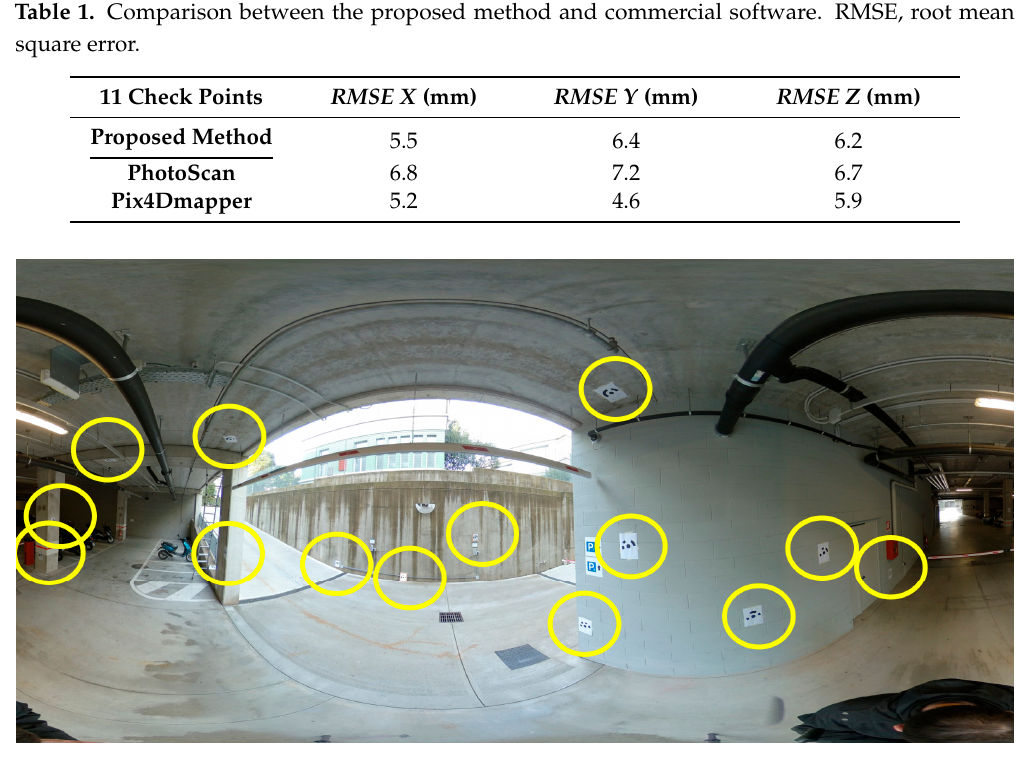
Figure 10. An image of the validation dataset generated.